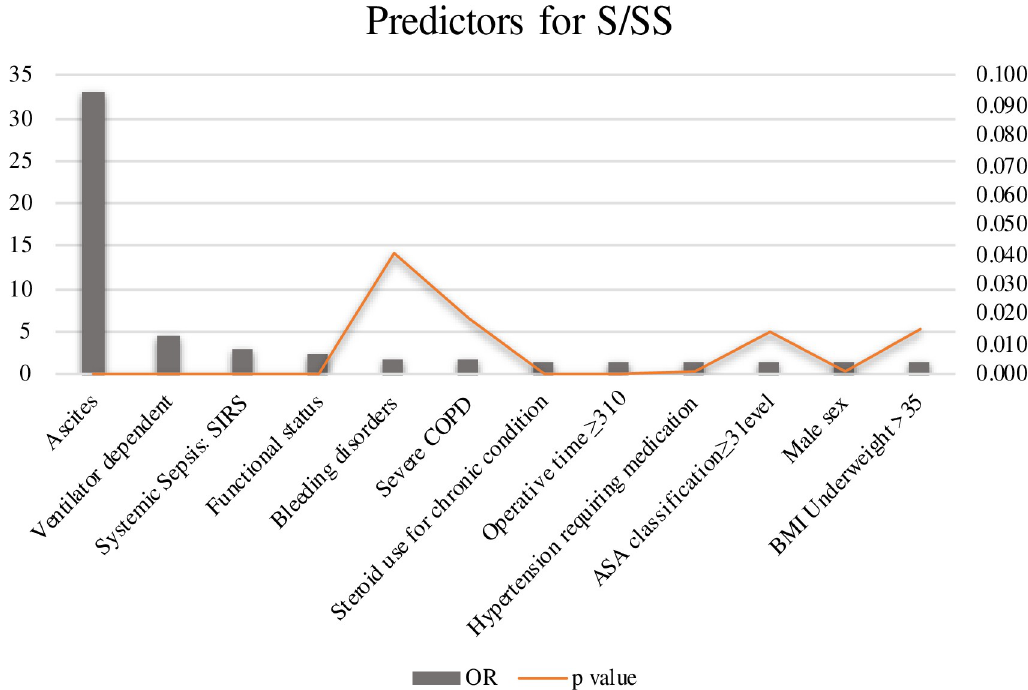
Fig 2. Predictors for S/SS, the abscissa shows the OR value. Y-axis on the left shows OR values, Y-axis on the right shows p values.